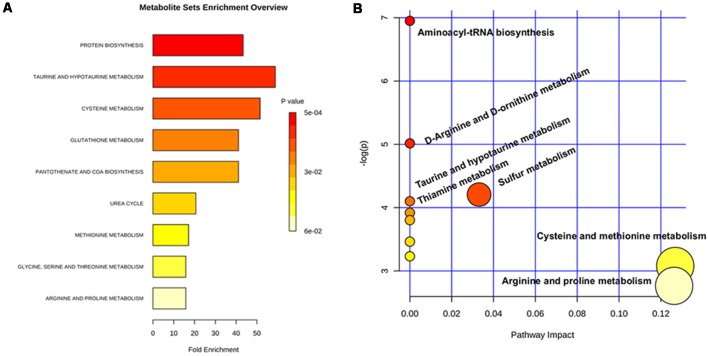
Metabolic pathway analysis based on the differentiated urine metabolites. (A) Overview of metabolite sets enrichment analysis based on the differentiated urine metabolites. (B) Urine metabolite-based metabolic pathway analysis.